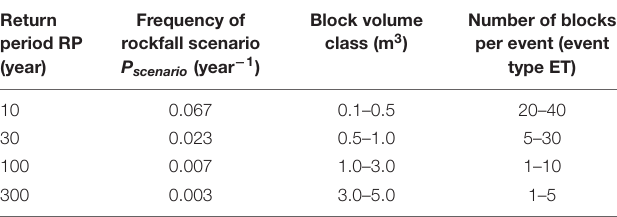
TABLE 2 | Rockfall scenarios considered in the risk